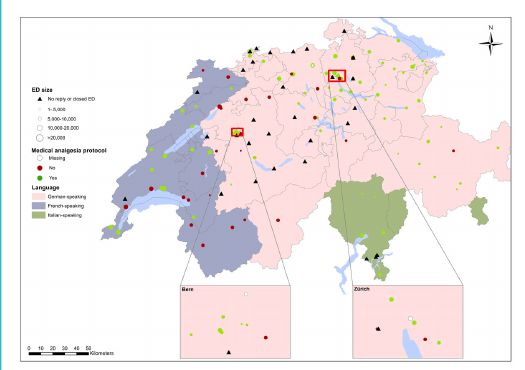
Figure 1: Emergency department (ED) location, stratified by par- ticipation, annual visit volume and medical pain management pro-